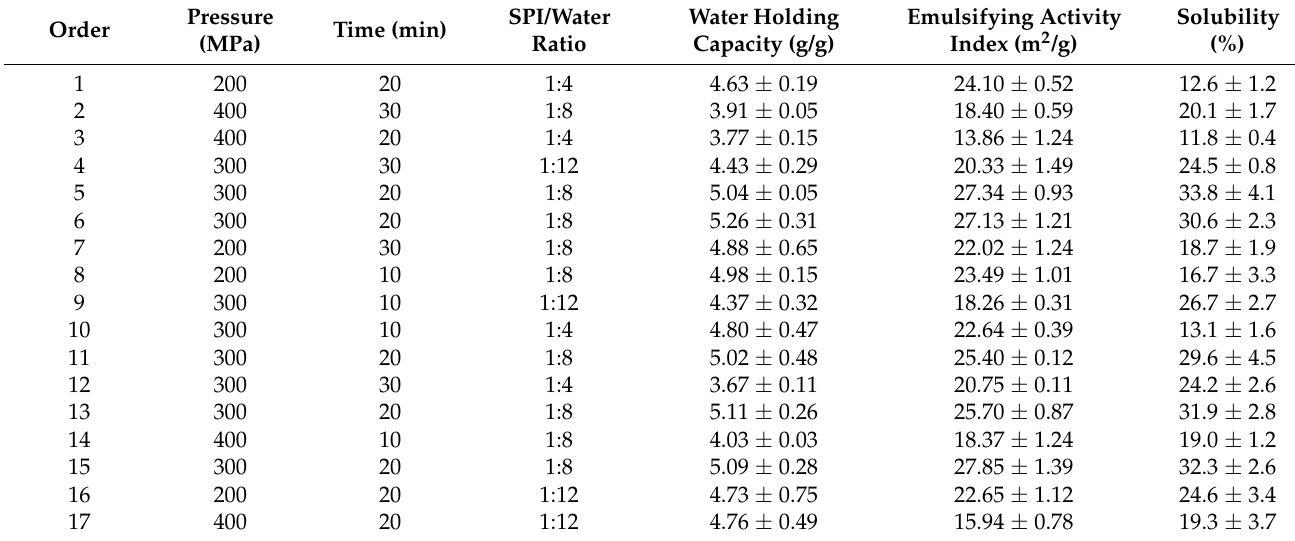
Table 1. High hydrostatic pressure treatment conditions for Box–Behnken experimental design and obtained functional properties of soy protein isolate